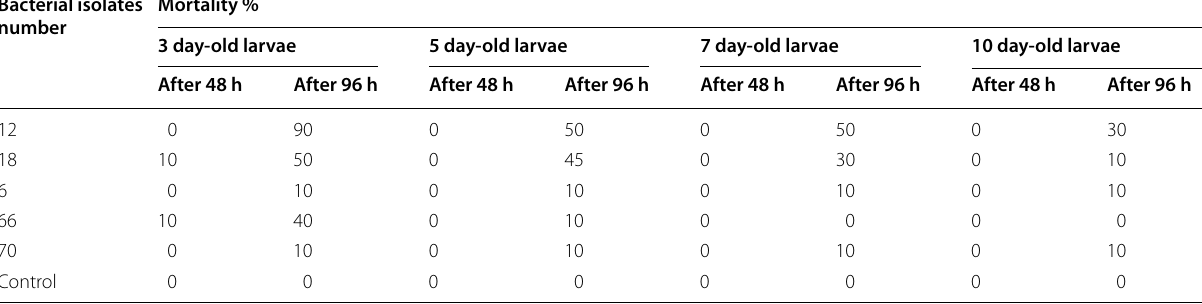
Table 2 Virulence of the most affected isolates on different days old larvae of the spiny bollworm Bacterial isolates Mortality number